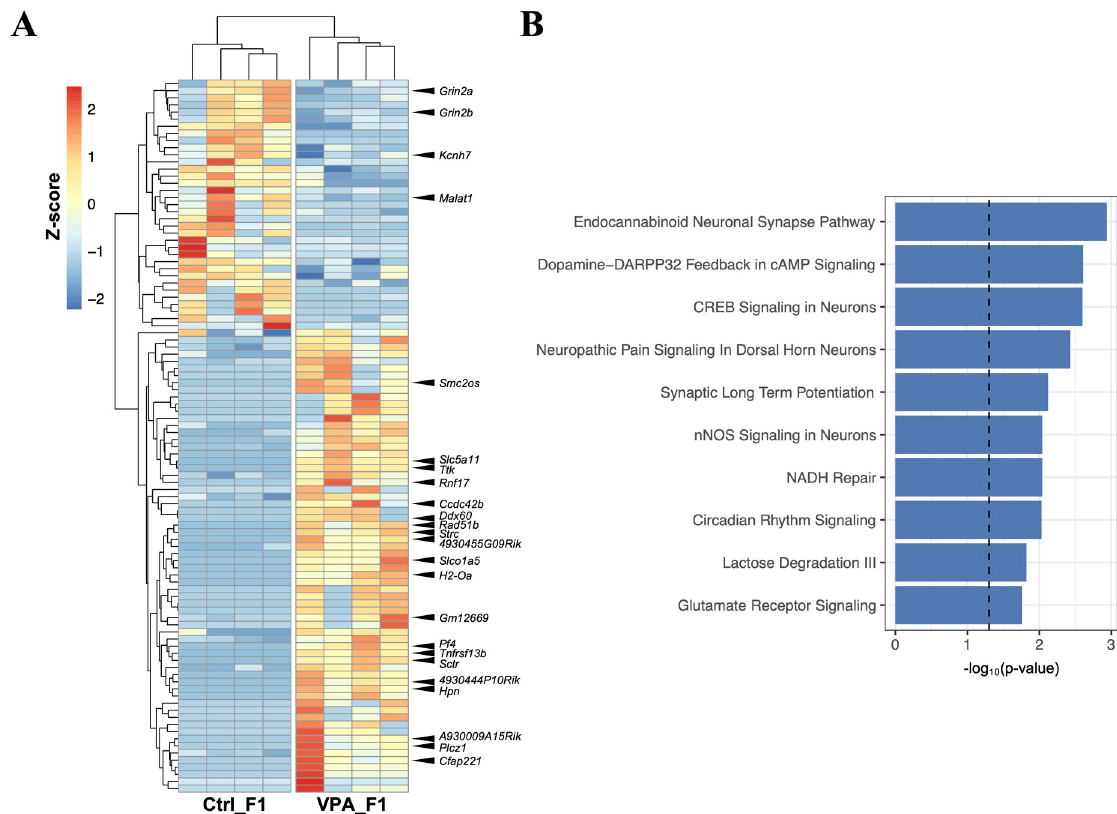
Fig 5. Brain RNA-seq for VPA-treated F1 (VPA_F1) and control group F1 (Ctrl_F1) mice. (A) Genes with P-value < 0.05 and two-fold change are shown in the heatmap (n = 4). q-value � 0.05 is indicated by arrowheads, and the gene name is attached. (B) Top canonical pathways generated by Ingenuity Pathway Analysis (IPA), using the genes with P-values < 0.05 and two-fold or greater expression as input. The dashed line indicates − log 10 (0.05).